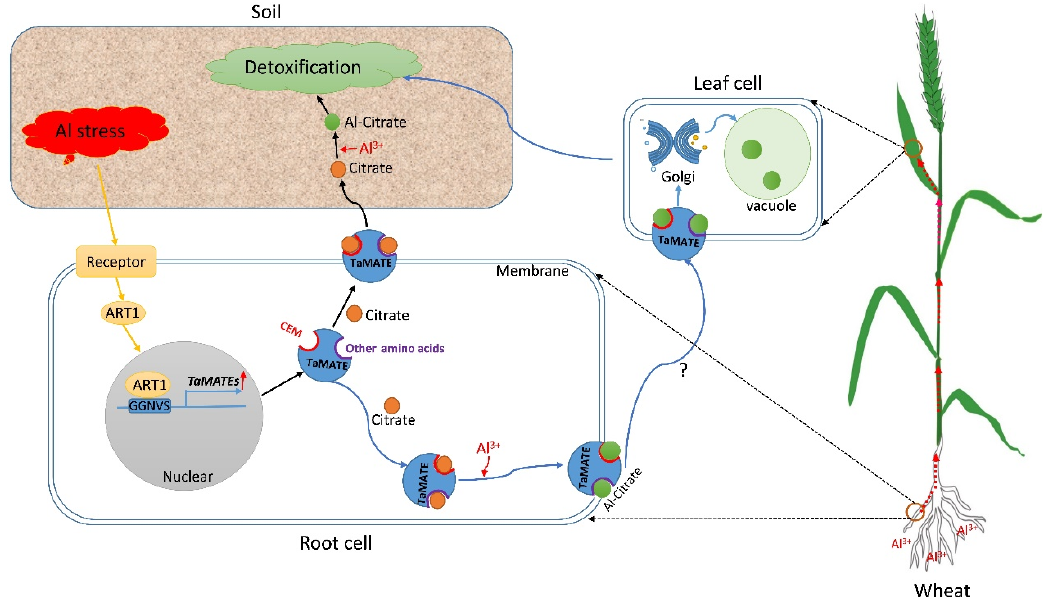
Figure 9. Putative regulatory network of TaMATEs under the treatment of Al 3+ in the wheat. ART1, Al resistance transcription factor; CEM, citrate exuding motif; TaMATEs represent the upregulation of TaMATE genes; represents the possible pathway for Al-citrate transfer by TaMATEs; represents Al-citrate transferred from root to leaf; represents the citrate; represents Al-citrate.